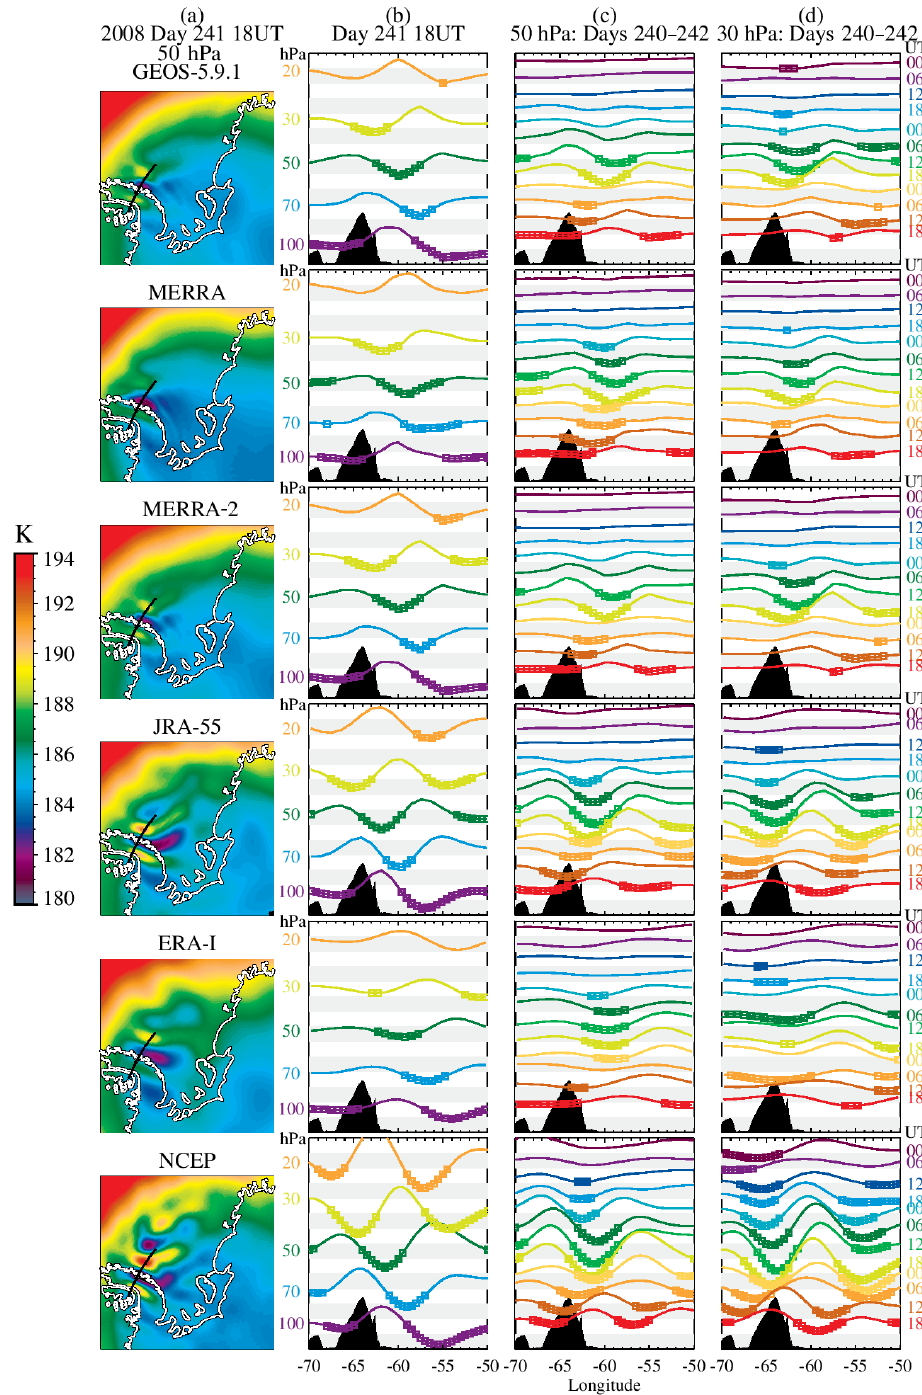
Figure 5. (a) Geographic distribution of 50hPa temperatures over a region of the Palmer Peninsula on 28 August 2008 (day 241) at 18:00UT for different reanalyses. (b) Longitudinal reanalysis temperature structure from − 70 ◦ to − 50 ◦ on the 100, 70, 50, 30, and 20hPa pressure levels along the 72 ◦ S latitude circle (shown as a black line in panel a ). The ordinate is an arbitrary temperature scale with offset colored lines representing the longitudinal temperature variation for each of the labeled pressure levels. (c, d) Time series of the 50hPa (30hPa) reanalysis temperatures starting from 27 August (d240) at 00:00UT and ending on 29 August (d242) at 18:00UT. The ordinate is an arbitrary temperature scale with offset colored lines representing the temperature variation at the 6-hourly intervals labeled on the right. In panels (b, c, d) , temperatures below the ice frost point are highlighted by square symbols, and mountain terrain is indicated by the black shading. Gray/white shading denotes both 5K temperature bands and 500m terrain